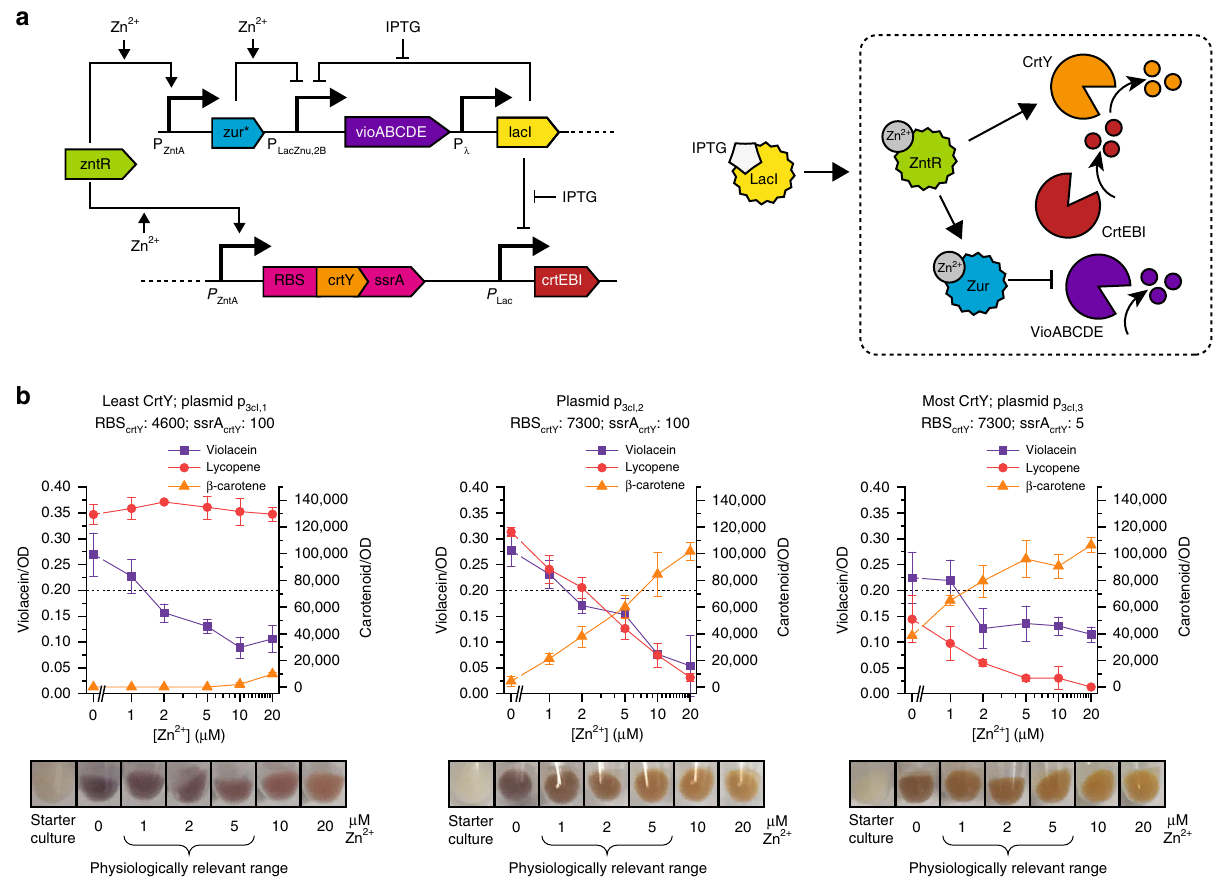
Fig. 4 Multi-color sensor cells respond to physiological zinc concentrations. a Circuit diagram and schematic depicting the design of tunable sensor cells. During the pre-assay culture stage, LacI represses all pigment production. IPTG addition activates the pigment production module, which is indicated by the dashed box. ZntR controls expression of both Zur and CrtY. At a threshold zinc concentration, Zur will repress expression of the violacein pathway, leading to cells that are red at intermediate zinc concentrations. Increasing amounts of zinc also lead to increased amounts of CrtY, which converts lycopene to beta-carotene. Modulation of the RBS and ssrA tag on CrtY can be used to tune the red to orange transition point. b Pigment quanti fi cation and visualization of sensor cells grown in minimal medium containing glycerol. All sensor cells have violacein off points between 1 and 2 µ M, and the lycopene to β -carotene transition points vary based on the expression levels of CrtY. The best performing sensor cells (containing plasmid p 3cI,2 ) have moderate CrtY expression and are visibly purple, red, and orange across a physiologically relevant range of zinc concentrations. The dotted line indicates the threshold for visible violacein. Source data for b are provided in the Source Data fi